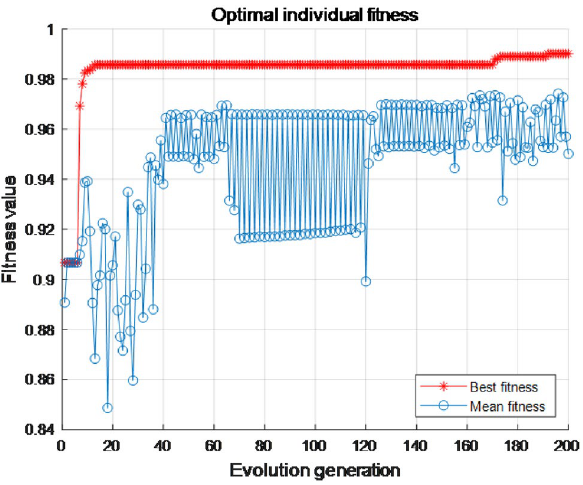
Figure 7. The fitness curve of the proposed